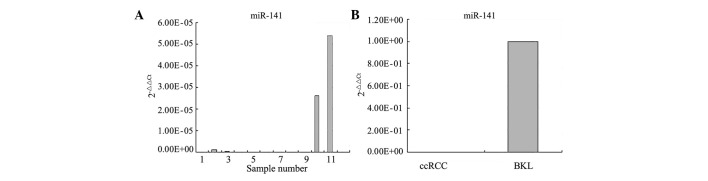
Individual (A) and general (B) relative quantification for miR-141 in serum samples from patients with ccRCC compared with those with BKL. ccRCC, clear cell renal cell carcinoma; BKL, benign kidney lesion.